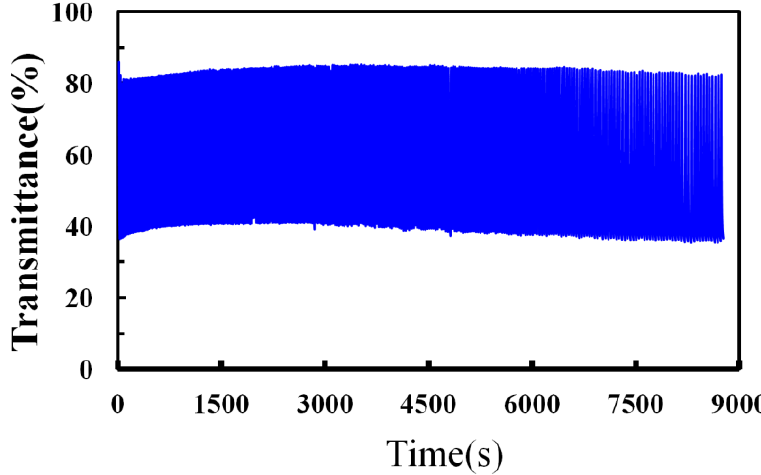
Figure 11. Life cycle measurements for the IZTO-based ECDs by CA measurements under 0.2 V~ − 1.0 V for 30